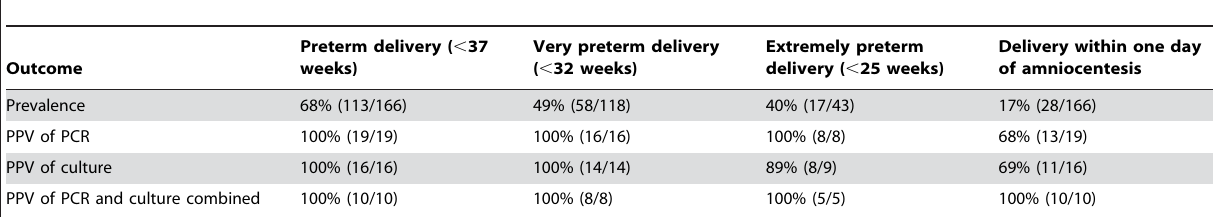
Table 2. Positive Predictive Value (PPV) of Amniotic Fluid PCR and Culture for Pregnancy Outcomes.